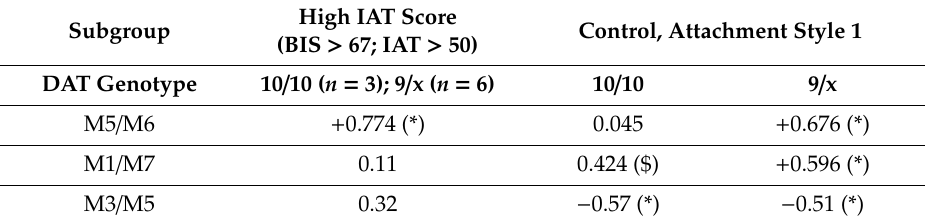
Table 3. Presence of positive or negative